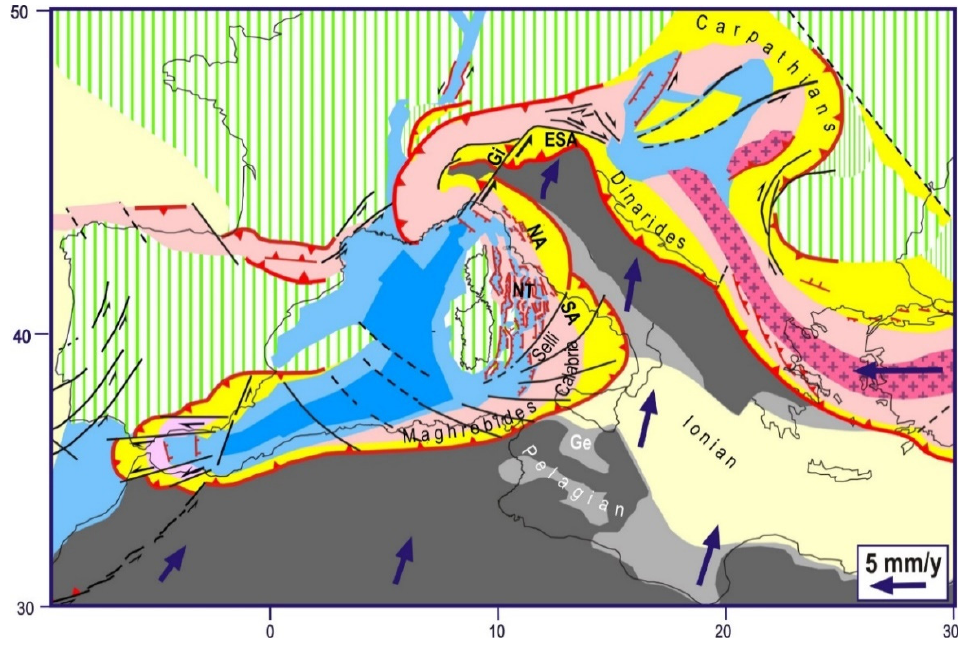
Figure 5. Late Miocene. The reactivation of the Giudicarie fault system (Gi), around the Tortonian, allowed the main Adriatic domain to move roughly NE ward with respect to its northwestern edge. The consequent divergence between the main Adriatic domain and the fixed Corsica-Sardinia block induced crustal extension in the interposed sector of the Alpine–Apennine belt, forming the Northern Tyrrhenian basin (NT). ESA = Eastern Southern Alps; NA = Northern Apennines; SA = Southern Apennines.